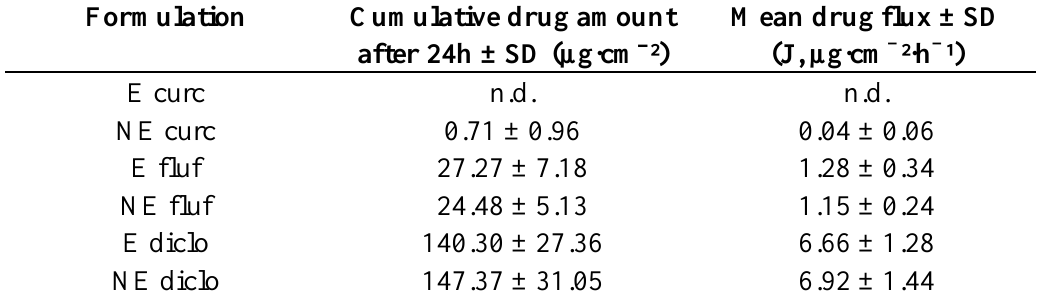
Table 5. Skin permeation rates of curcumin (curc), flufenamic acid (fluf) and diclofenac acid (diclo) from macroemulsions (E) and nanoemulsions (NE) expressed as cumulative permeated drug amounts (µg·cm −2 ) and mean drug fluxes (J, µg·cm −2 ·h −1 ). At least five experiments were performed for each formulation (n ≥ 5); indicated values